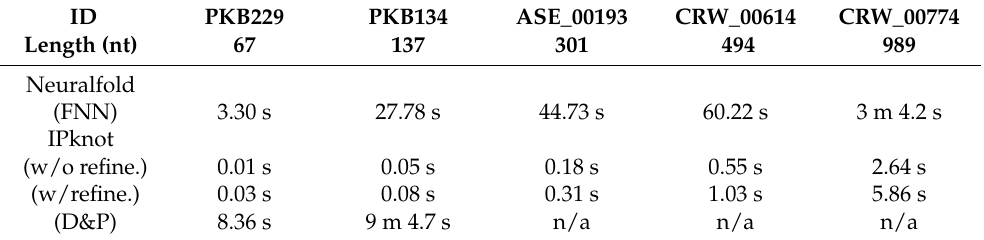
Table 3. Computation time for calculating base-pairing probabilities of sequences of various lengths.